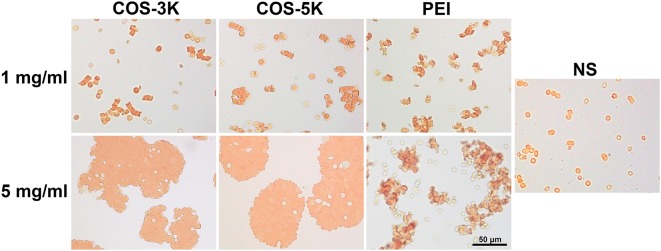
Pictures of RBC aggregation induced by COS under an optical microscope. RBC incubated with PEI was positive control. PEI, polyetherimide; NS, normal saline.